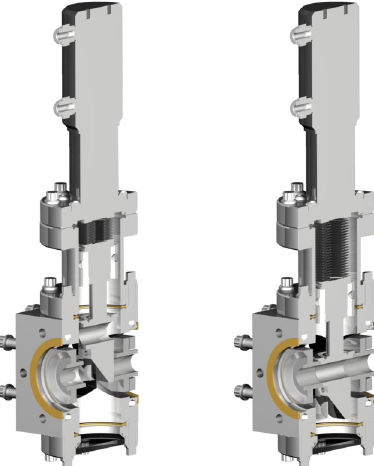
FIG. 13. CAD rendering of a pop-in screen showing symme- trized insertion of the vacuum pipe when the screen is with-